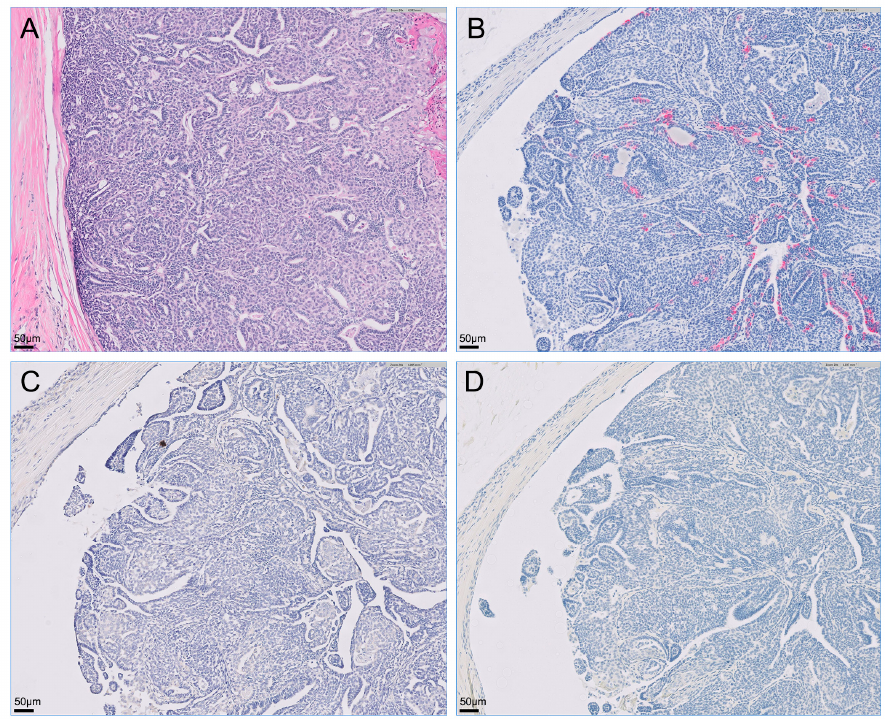
Figure 3. Microscopy of the right metatarsal skin mass visualized with hematoxylin ‒ eosin staining and immunohistochemistry. Primary cutaneous tumor on the dorsum of the right metatarsal region was intensely positive for cytokeratin 7 via immunostaining but was negative for cytokeratin 20 and S100 proteins via staining on immunohistochemistry. ( A ) Hematoxylin ‒ eosin stain; ( B ) immuno- histochemistry for cytokeratin 7; ( C ) immunohistochemistry for cytokeratin 20; ( D ) immunohisto- chemistry for S100s.